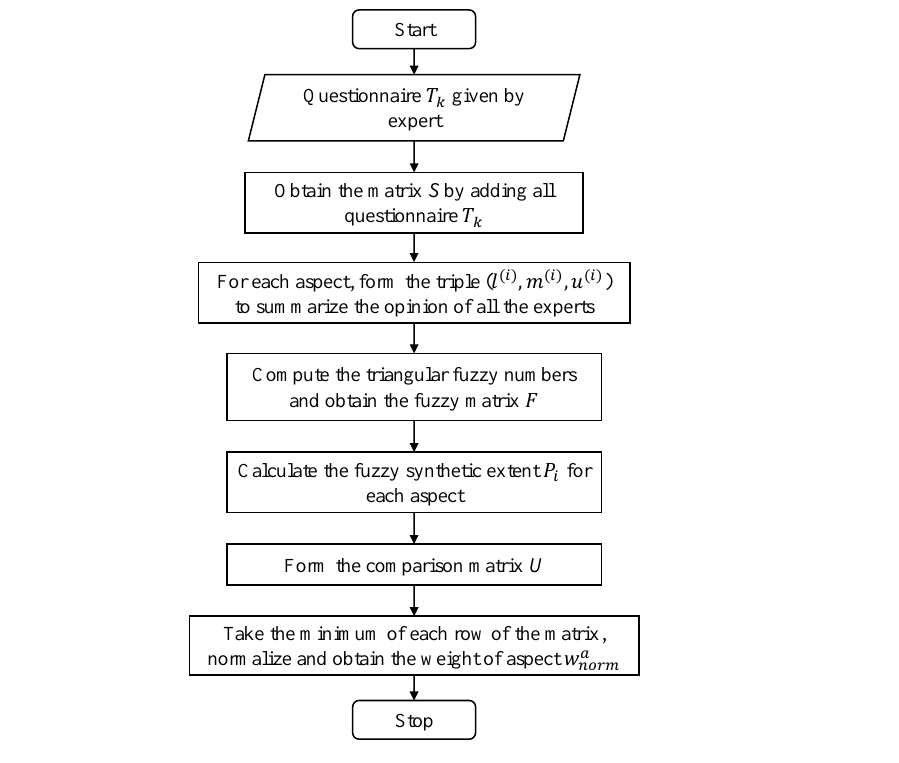
Figure 4. The flow chart of the FAHP